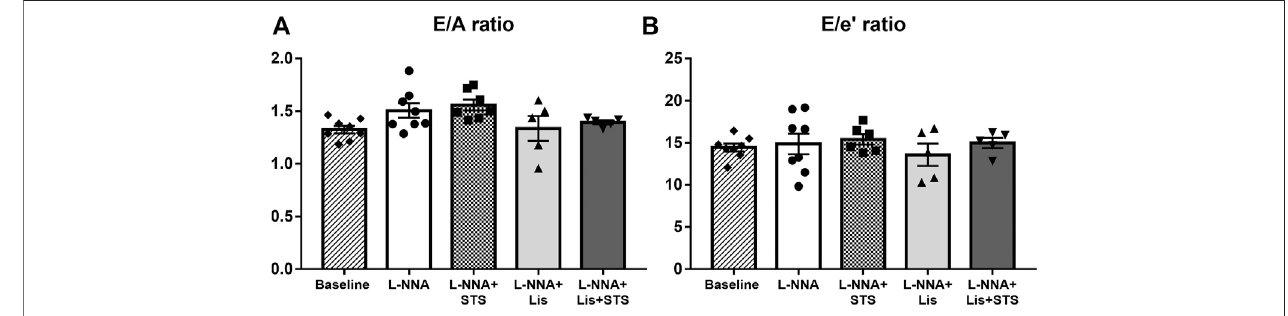
FIGURE3 | Diastolic function wasnot affected inL-NNA-induced hypertensive rats. Pulsed-wave and Tissue Doppler imaging were used to calculate (A) E/A ratio and (B) E/e ’ ratio to evaluate diastolic function. N (cid:2) 5 – 8.